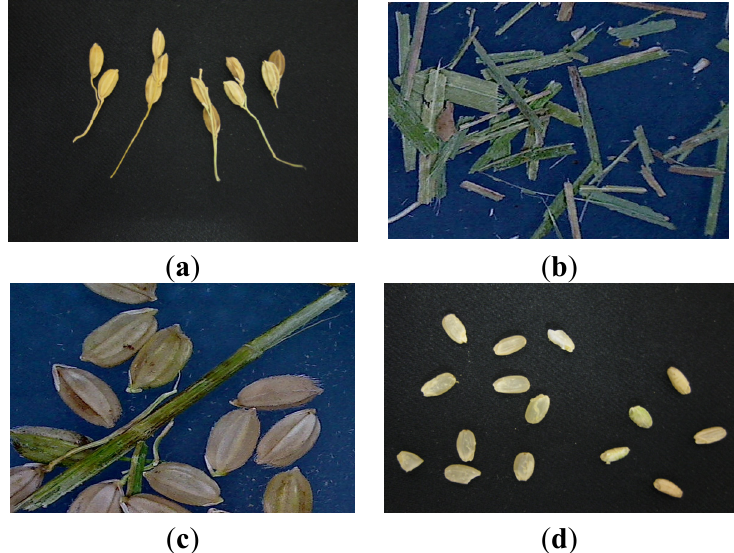
Figure 6. Object in harvested grains. ( a ) Long rachis branch; ( b ) grass; ( c ) stem; ( d ) brown and cracked